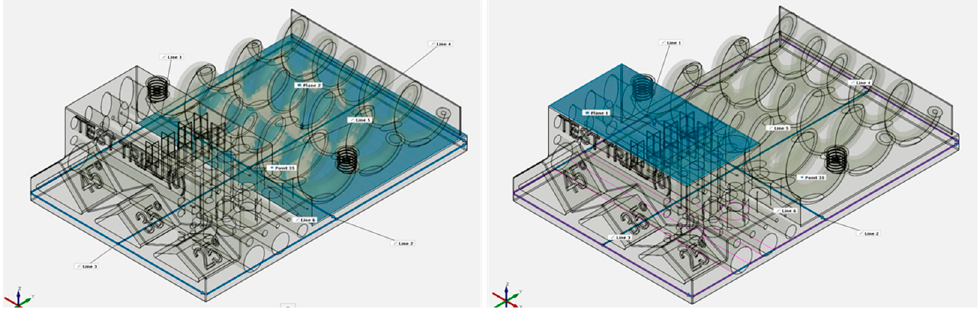
Figure 9. 3D scanner alignment used for the evaluation of the results: view of alignment on spirals ( left ), and on the top ( right ).